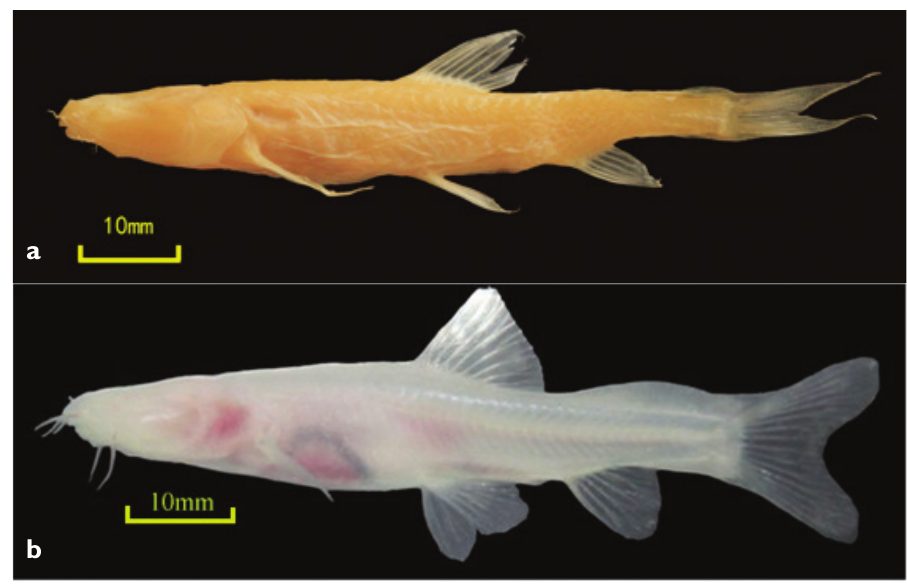
Figure 1. a Holotype of Oreonectes daqikongensis sp. n. NO.CNGZNU20110128002. b A living Oreonectes daqikongensis sp.